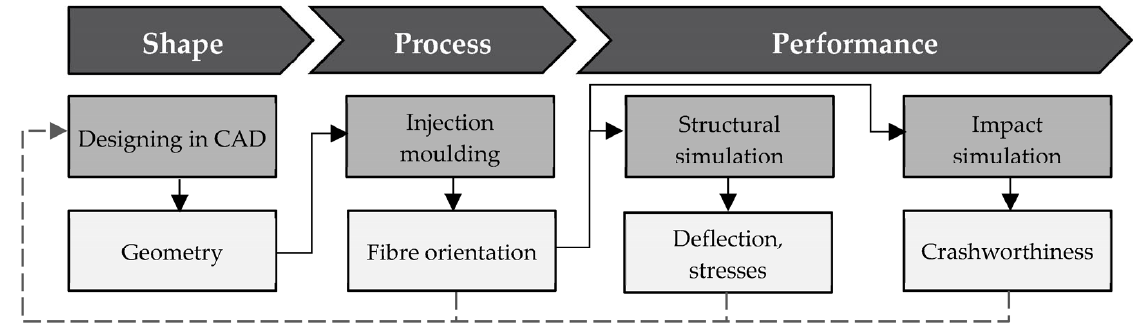
Figure 1. A schematic illustration of the component design process chain for SFRT.